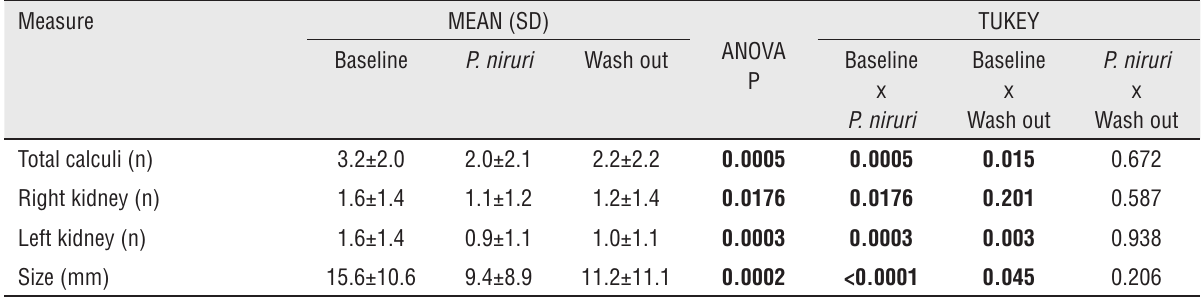
Table 3 - Number and size of upper urinary calculi in patients treated with P. niruri .